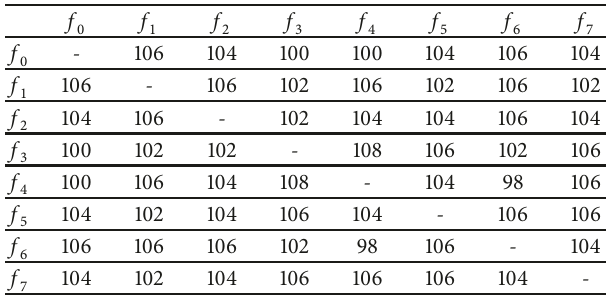
of the proposed bijective n × n S-boxes. i